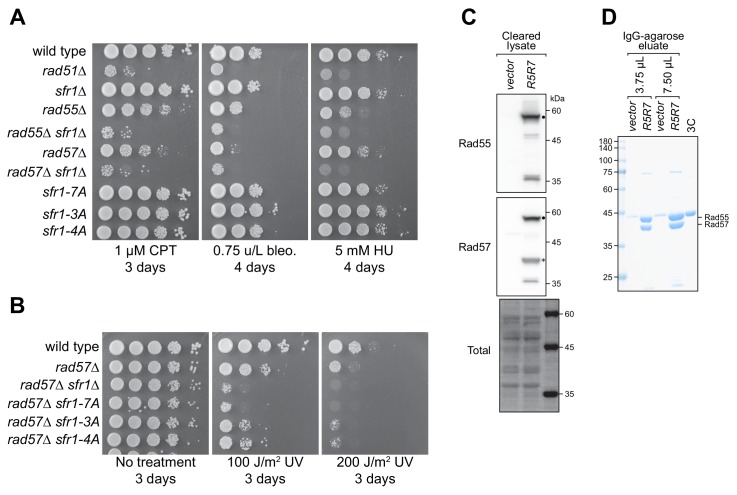
DNA repair in Sfr1-Rad51 interaction mutants is dependent on Rad57.(A,B) DNA damage sensitivity of the indicated strains was assessed. ‘No treatment’ plate for (A) is shown in Figure 7A. CPT, camptothecin. Bleo., bleomycin. HU, hydroxyurea. Note that sfr1Δ cells are not sensitive to the indicated doses of CPT, bleo. or HU unless Rad55/Rad57 is absent. (C) S. pombe was transformed with the REP1 and REP2 expression vectors (vector) or the same vectors encoding Rad55-Protein A and Rad57 (R5R7). Soluble cellular extracts were probed with the indicated antibodies. Black dot indicates the Rad55-Protein A band, which is also reactive to the anti-Rad57 antibody due to the Protein A tag. Asterisk indicates the Rad57 band. Total, Ponceau S-stained membrane. (D) Soluble extracts from (C) were incubated with IgG-agarose and bound proteins were eluted via addition of 3C protease, which cleaves between Rad55 and Protein A. The indicated amount of this eluate was analyzed by SDS-PAGE and CBB staining. 2 µg of 3C protease was loaded on the rightmost lane as a control. Size markers are indicated on the left in kDa.